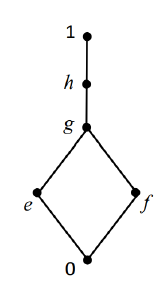
Figure 8. Lattice structure of Example